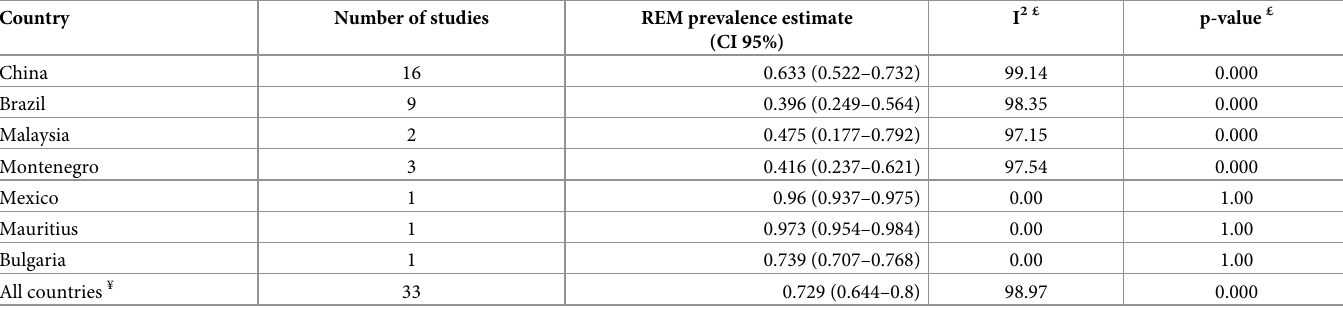
Table 2. Meta-analysis HCV prevalence results for each country and by all countries.